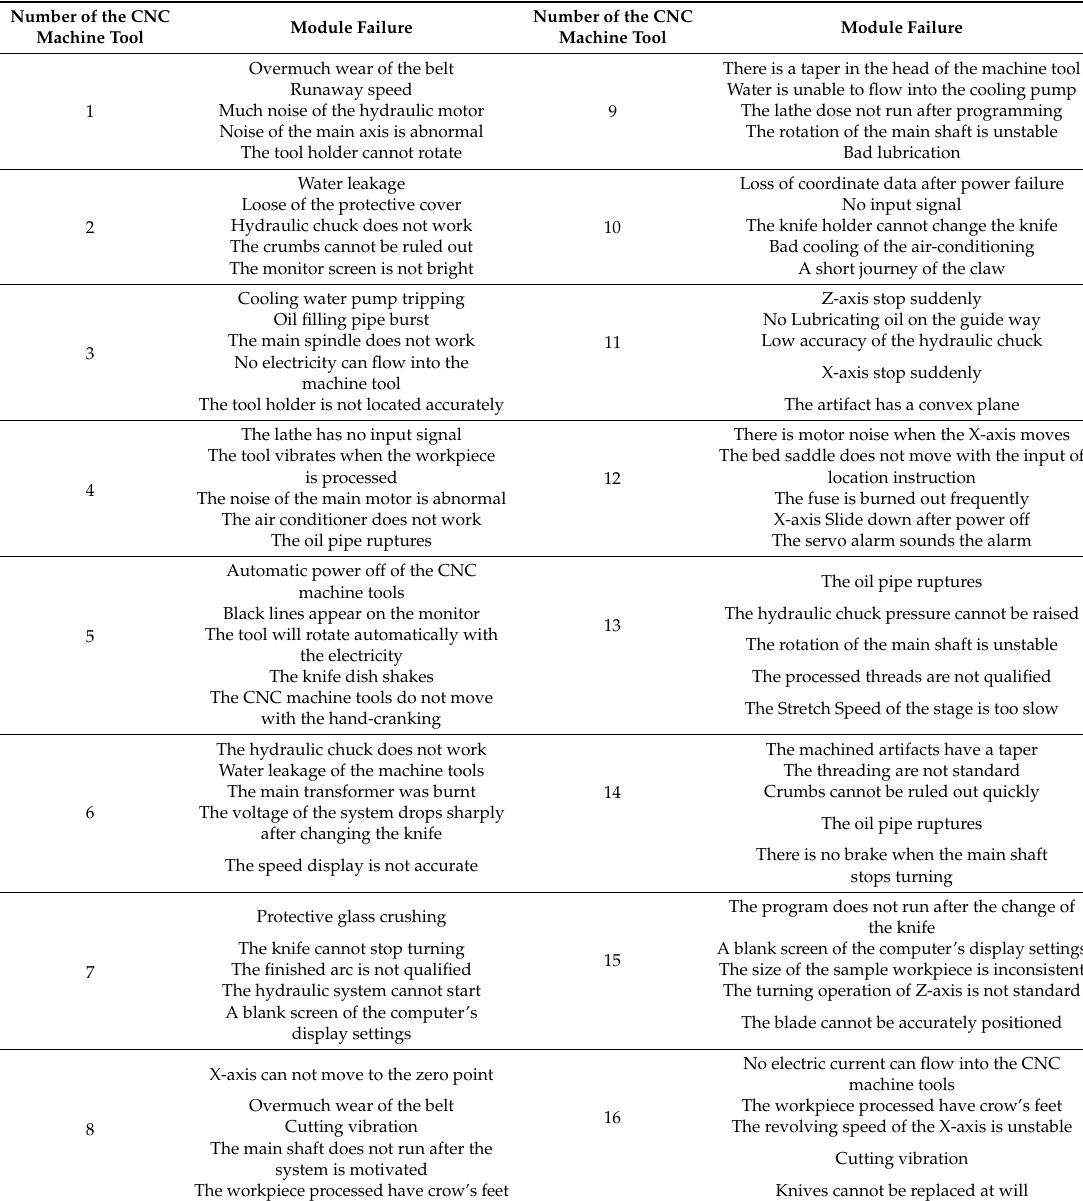
Table 1. Data about module failures for 16 computer numerically controlled (CNC) machine tools. Number of the CNC Machine